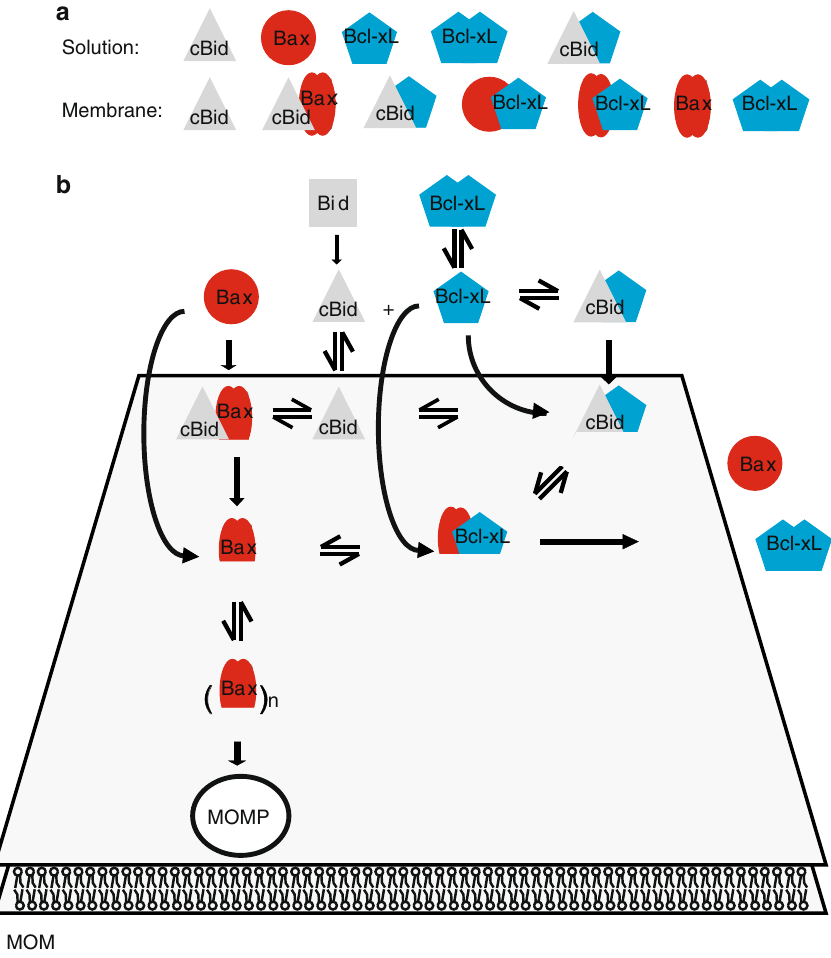
Fig. 8 Integrated model for the multiple interactions between Bcl-2 proteins in solution and in membranes to regulate MOM permeabilization. a Species detected in solution and membranes. Bax is schematically shown in two conformations corresponding to monomeric as fi lled red circles and the membrane- embedded as two red , fi lled ovals . For the Bax/Bcl-xL complex, we showed that a complex containing oligomeric Bax exists, whereas we suggest the existence of the complex containing monomeric Bax. b Schematic representation of an integrated model of Bcl-2 protein interaction network in solution and at the MOM. MOM mitochondrial outer